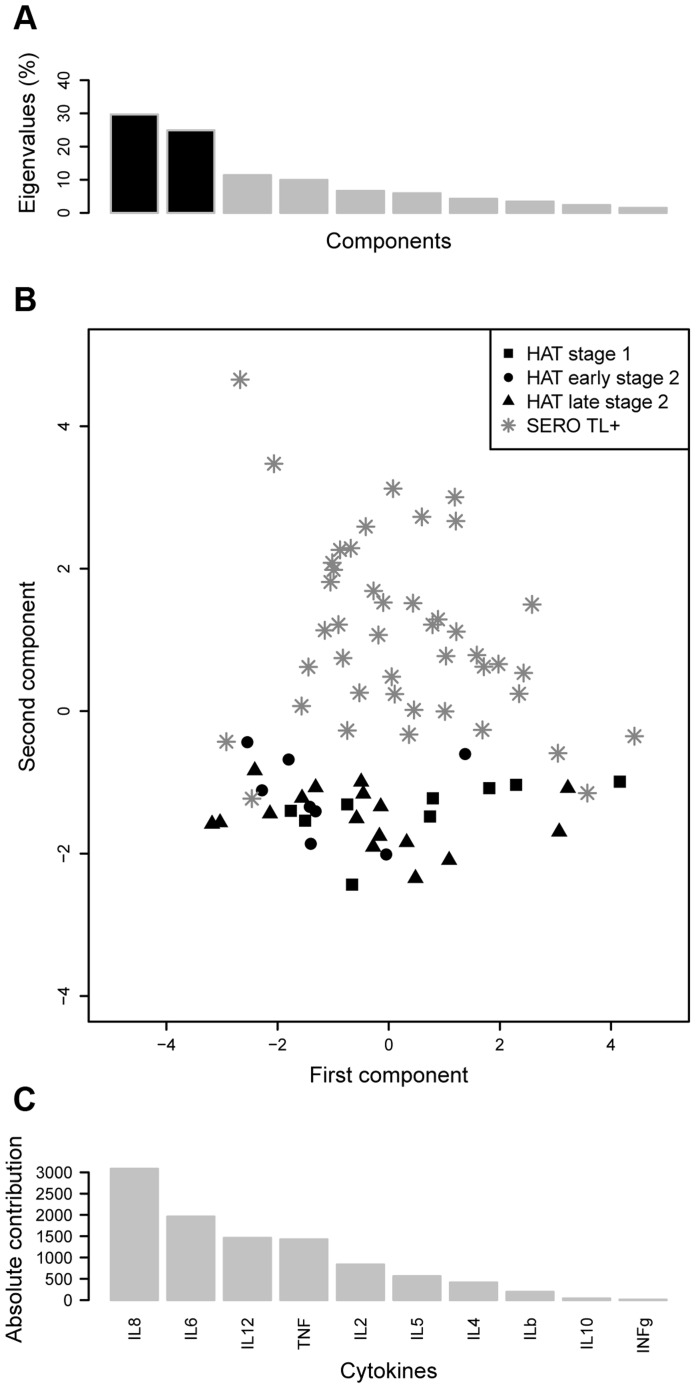
Principal component analysis of cytokine responses in HAT patients and SERO TL+.A. Histogram of eigenvalues. The eigenvalues, which corresponds to the amount of variance accounted by each component, are presented for the first ten components. The two first components, which explain more than 50% of the total variance, are in black. B. First factorial plan (x-axis: first component, y-axis: second component). The plan composed by the two first axis or dimensions is represented. It corresponds to an approximation of the cloud of points by a 2-dimensional space. C. Absolute contribution of each cytokine to the variance of the second component.